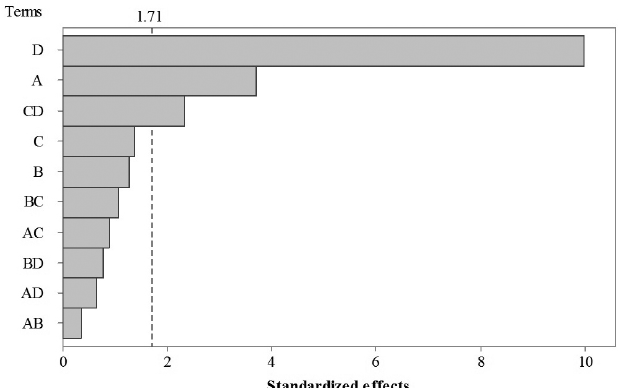
FIGURE 1 - Pareto chart for effects of time of dissolution (A), volume f dissolution media (B), pH of dissolution media (C), rotation speed (D), and their interactions (AB, AC, AD, BC, BD, and CD) on the amount of acetaminophen dissolved.